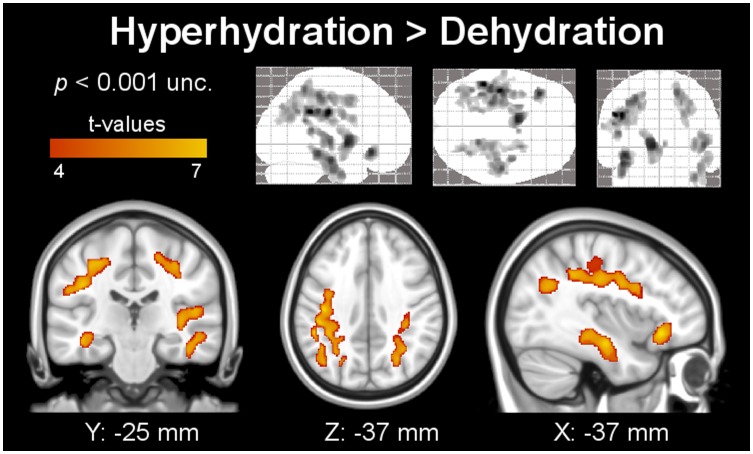
Segmented clusters of the white matter with significant extension during hyperhydration compared to dehydration in parietal and tempo-parietal regions (indicated by the color code) obtained using VBM.The upper row shows the results as grayscale Maximum Intensity Projection onto the standard SPM glass brain in coronal, axial and sagittal view.